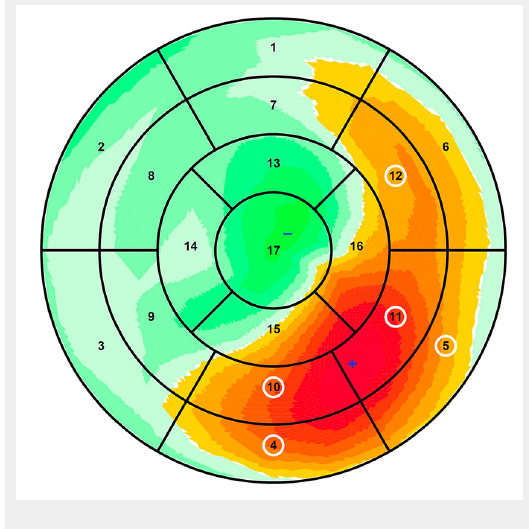
Polarmap of the unipolar epicardial surface potentials obtained at the J-point with ECG imaging in a patient with an left circumflex artery occlusion. Epicardial unipolar potential distribution obtained from J-point measurements. Yellow to red areas indicate positive potentials and green areas indicate negative potentials. Following the American Heart Association standard 17 segment model, the central part of the image corresponds to the left-ventricular apex and the outermost segments correspond to the basal part of the left ventricular